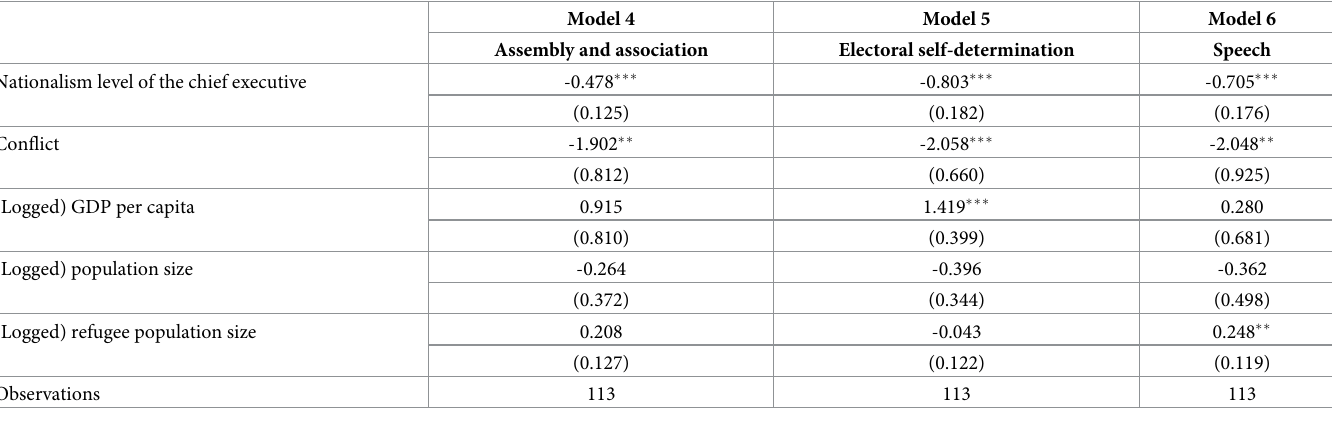
Table 2. Ordered logit estimates of CIRI scores in partial